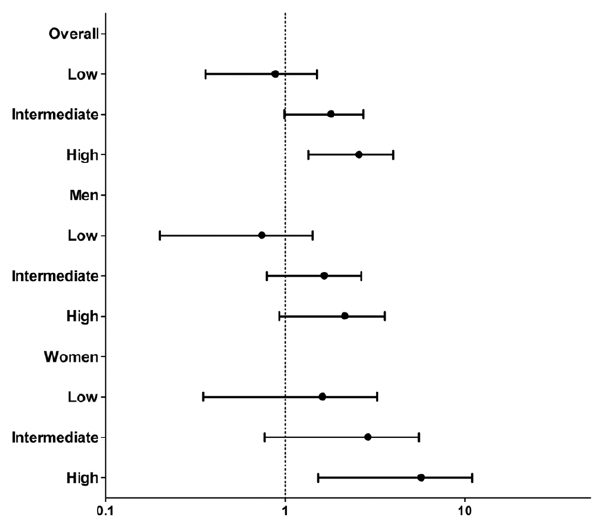
Figure 4. Standardized mortality ratio ( SMR ) according to risk stratification. The x-axis represents SMR with 95% confidence interval in log scale. The y-axis represents overall and gender subgroup of IgAN